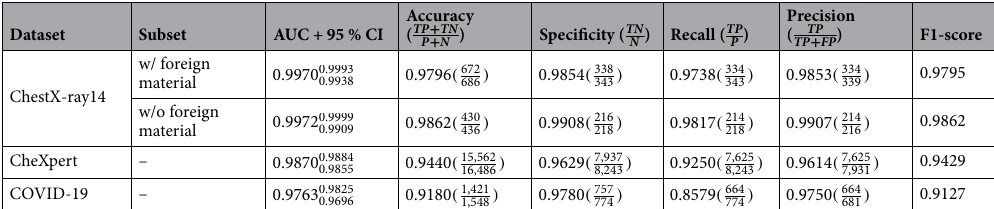
Table 2. Comparison of the verification performance on two different subsets of the ChestX-ray14 dataset that either contain foreign material or not (first two rows). Furthermore, we show the verification results for the CheXpert dataset and the COVID-19 Image Data Collection (last two rows). We present the AUC (together with the lower and upper bounds of the 95% confidence intervals from 10,000 bootstrap runs), the accuracy, the specificity, the recall, the precision, and the F1-score.